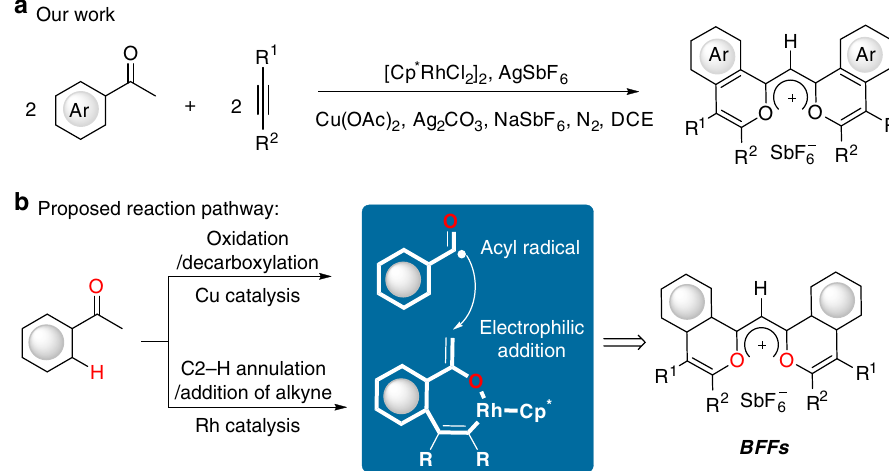
Fig. 2 Merging radical chemistry with C – H activation to construct BFFs. a In this report, one step synthesis of BFFs. b The proposed reaction